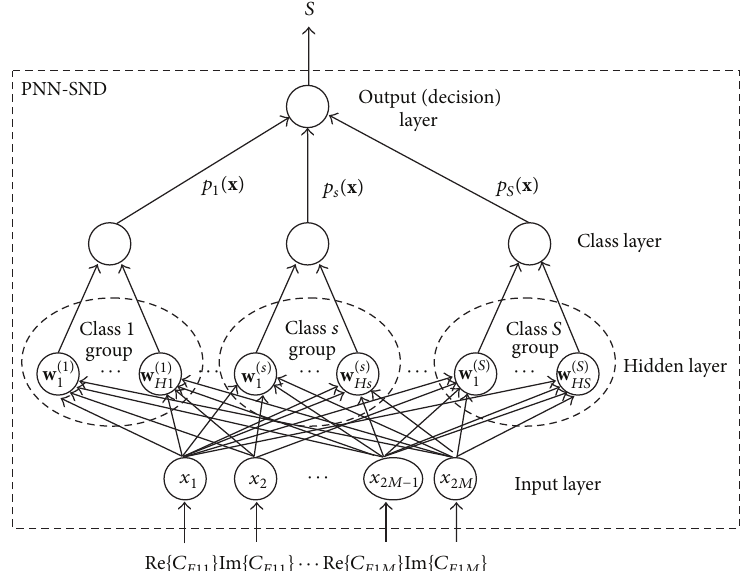
Figure 3: PNN for determination of the number of stochastic EM sources, 𝑠 , in the observed spatial